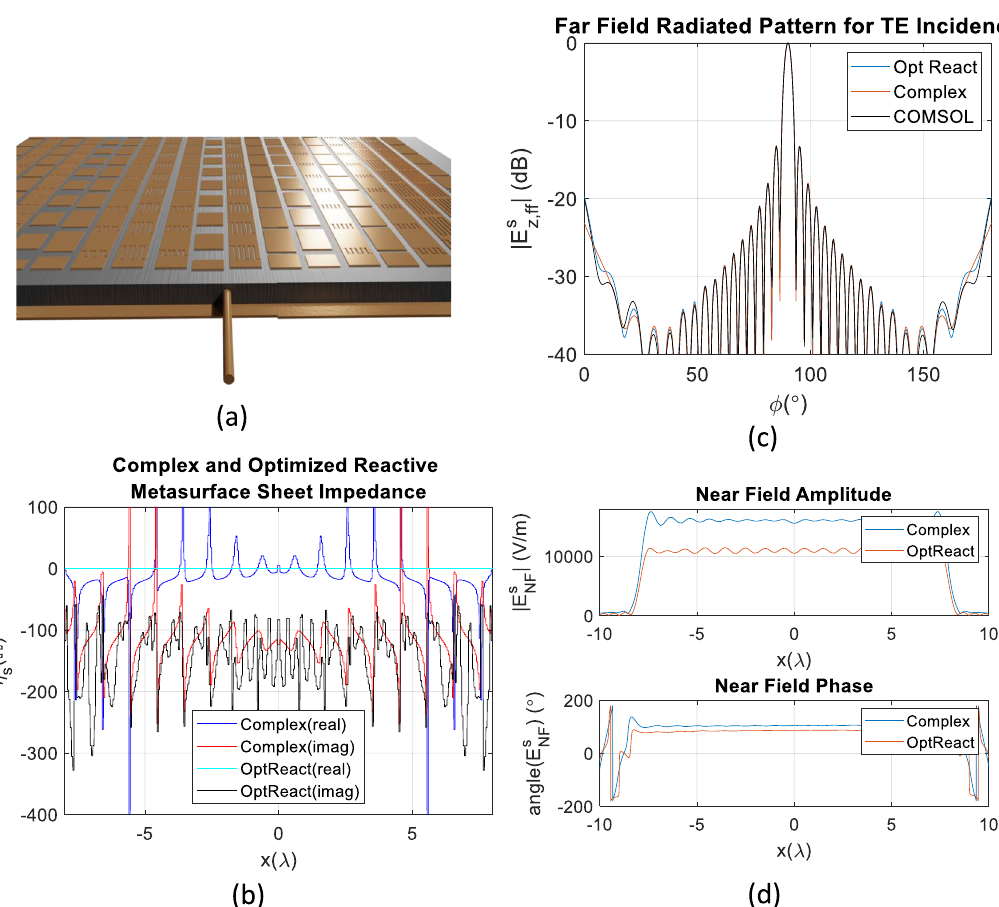
Figure 23: (Reprinted with permission from Ref. [52]). (a) A metasurface antenna consisting of a patterned metallic cladding supported by a groundeddielectricsubstratefedbyanin fi niteelectriclinesourceplacedwithinthesubstrate.Thegeometryis fi niteinthetransversedirections andin fi niteintheaxialdirectionandhencetheelectromagneticsproblemis2-dimensional.(b)Theinitialcomplex-valuedsheet impedanceand the optimized reactive sheet impedance. (c) Far fi elds of the complex-valued sheet design, the optimized reactive sheet design, and a full wave veri fi cation of the optimized reactive sheet design in COMSOL. (d) Backprojected far fi elds to the metasurface plane to show aperture fi